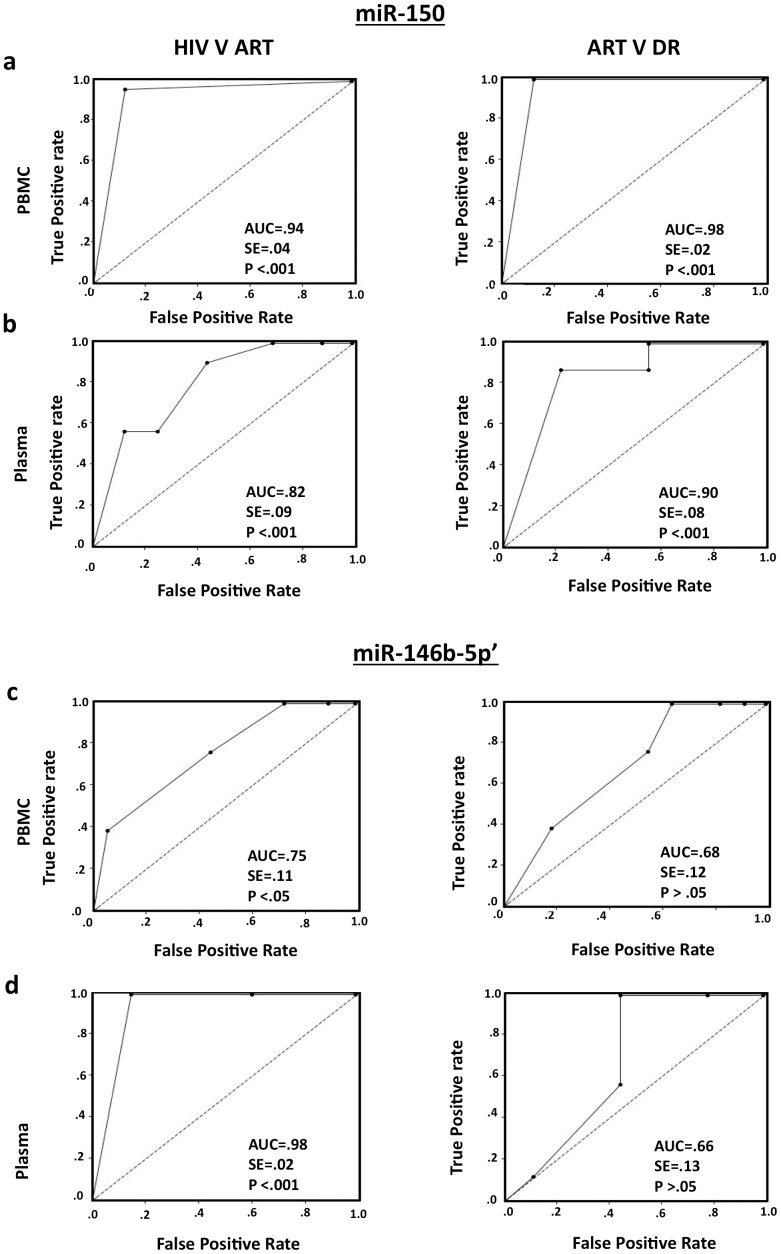
miRNAs as classifiers for patients without and with ART.Receiver operating characteristic (ROC) curve analysis of expression ratio of (a) PBMC miR-150/RNU-44, (b) plasma miR-150/miR-16, (c) PBMC miR-146b-5p/RNU-44 and (d) plasma miR-146b-5p/miR-16, as classifier of Set-C (HIV+; asymptomatic and symptomatic) versus Set-D (patients on ART) shown on left panels; and Set-D versus Set-E (ART resistance patients) shown on right panels. Insets of plots show area under curve (AUC), standard error (SE) and significance (p value).